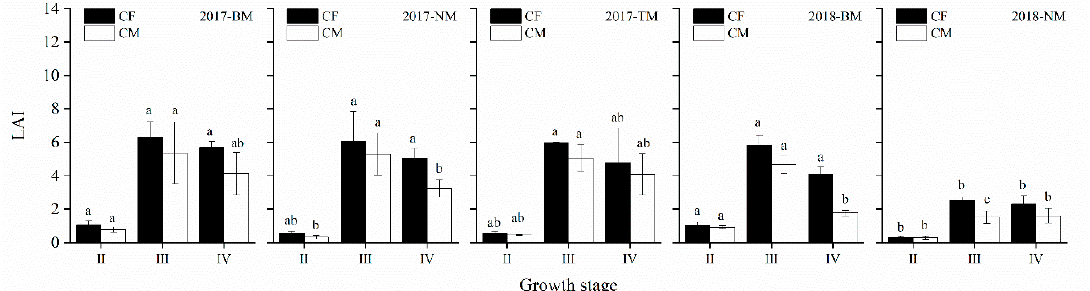
Figure 5. Leaf area index at the end of three growth stages at Wuwei, China: Ⅱ seedling stage on June 10, Ⅲ tuber initiation stage on July 13 and Ⅳ tuber bulking stage on August 5 for the different kinds of fertilizer and different soil surface treatments: inorganic fertilizer (IF) and cattle manure (CM); black plastic-film mulch (BM), transparent film-plastic mulch (TM) and no mulch (NM) during 2017 and 2018. Note: different letters (a, b, c and d) on points indicates that the differences among values with different treatments at the same growth stage were significant at the p < 0.05 level according to the LSD test. Bars represent standard deviations ( n = 3). Values are the means of three replicates.